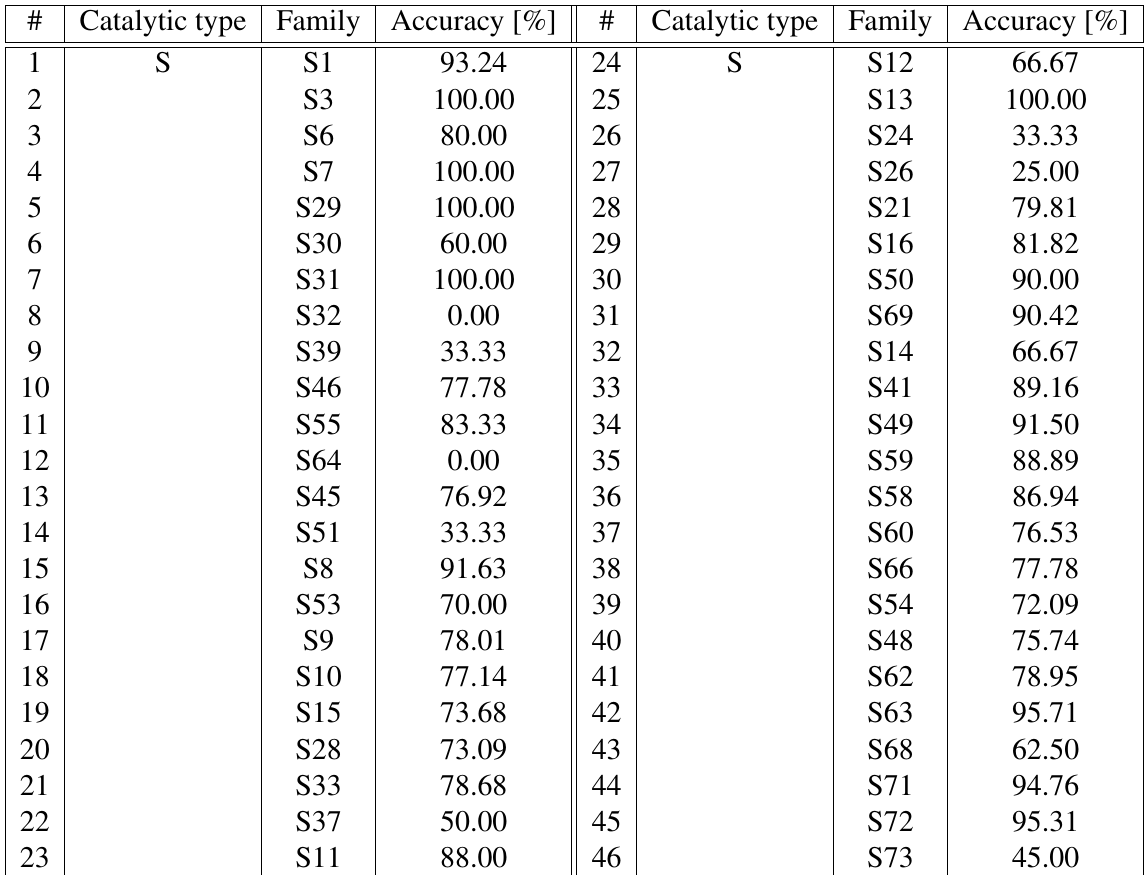
Table 11: Accuracy values for the SVM system for families from catalytic type S.